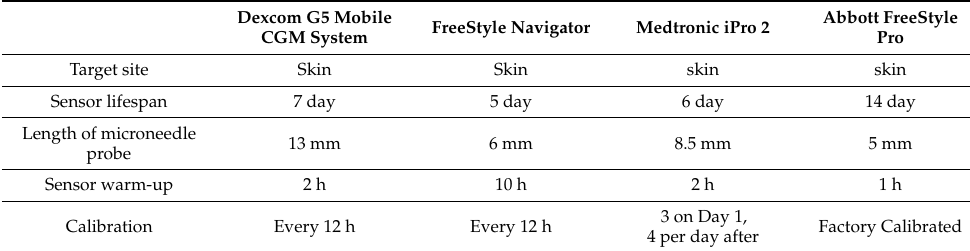
Table 1. Characteristics of the commercial continuous glucose monitoring systems.